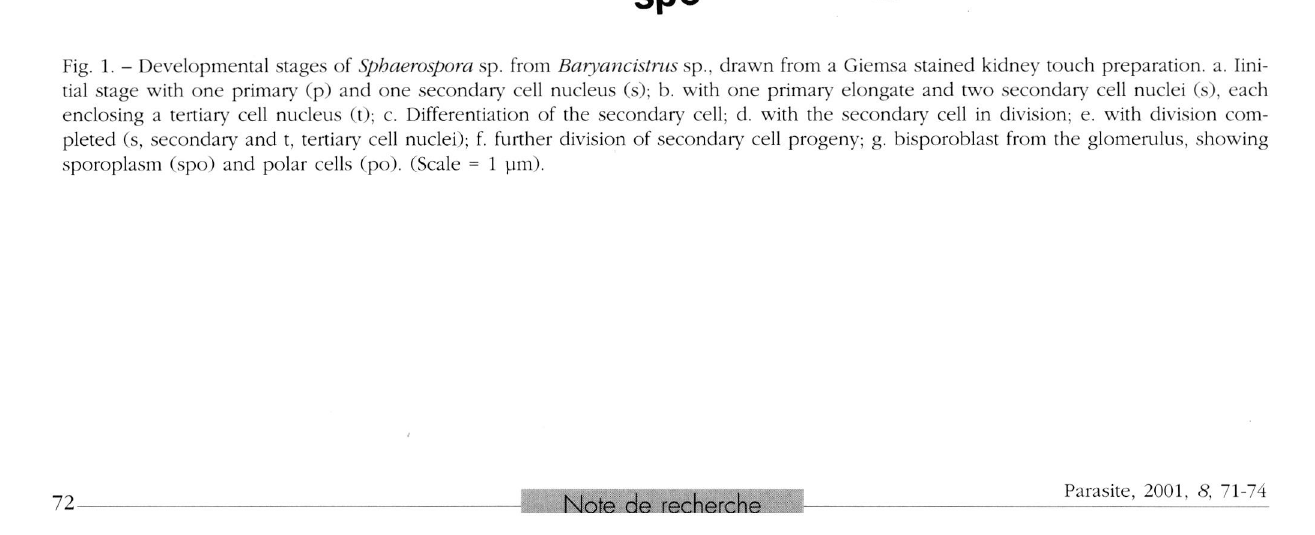
Parasite, 2001, 8,